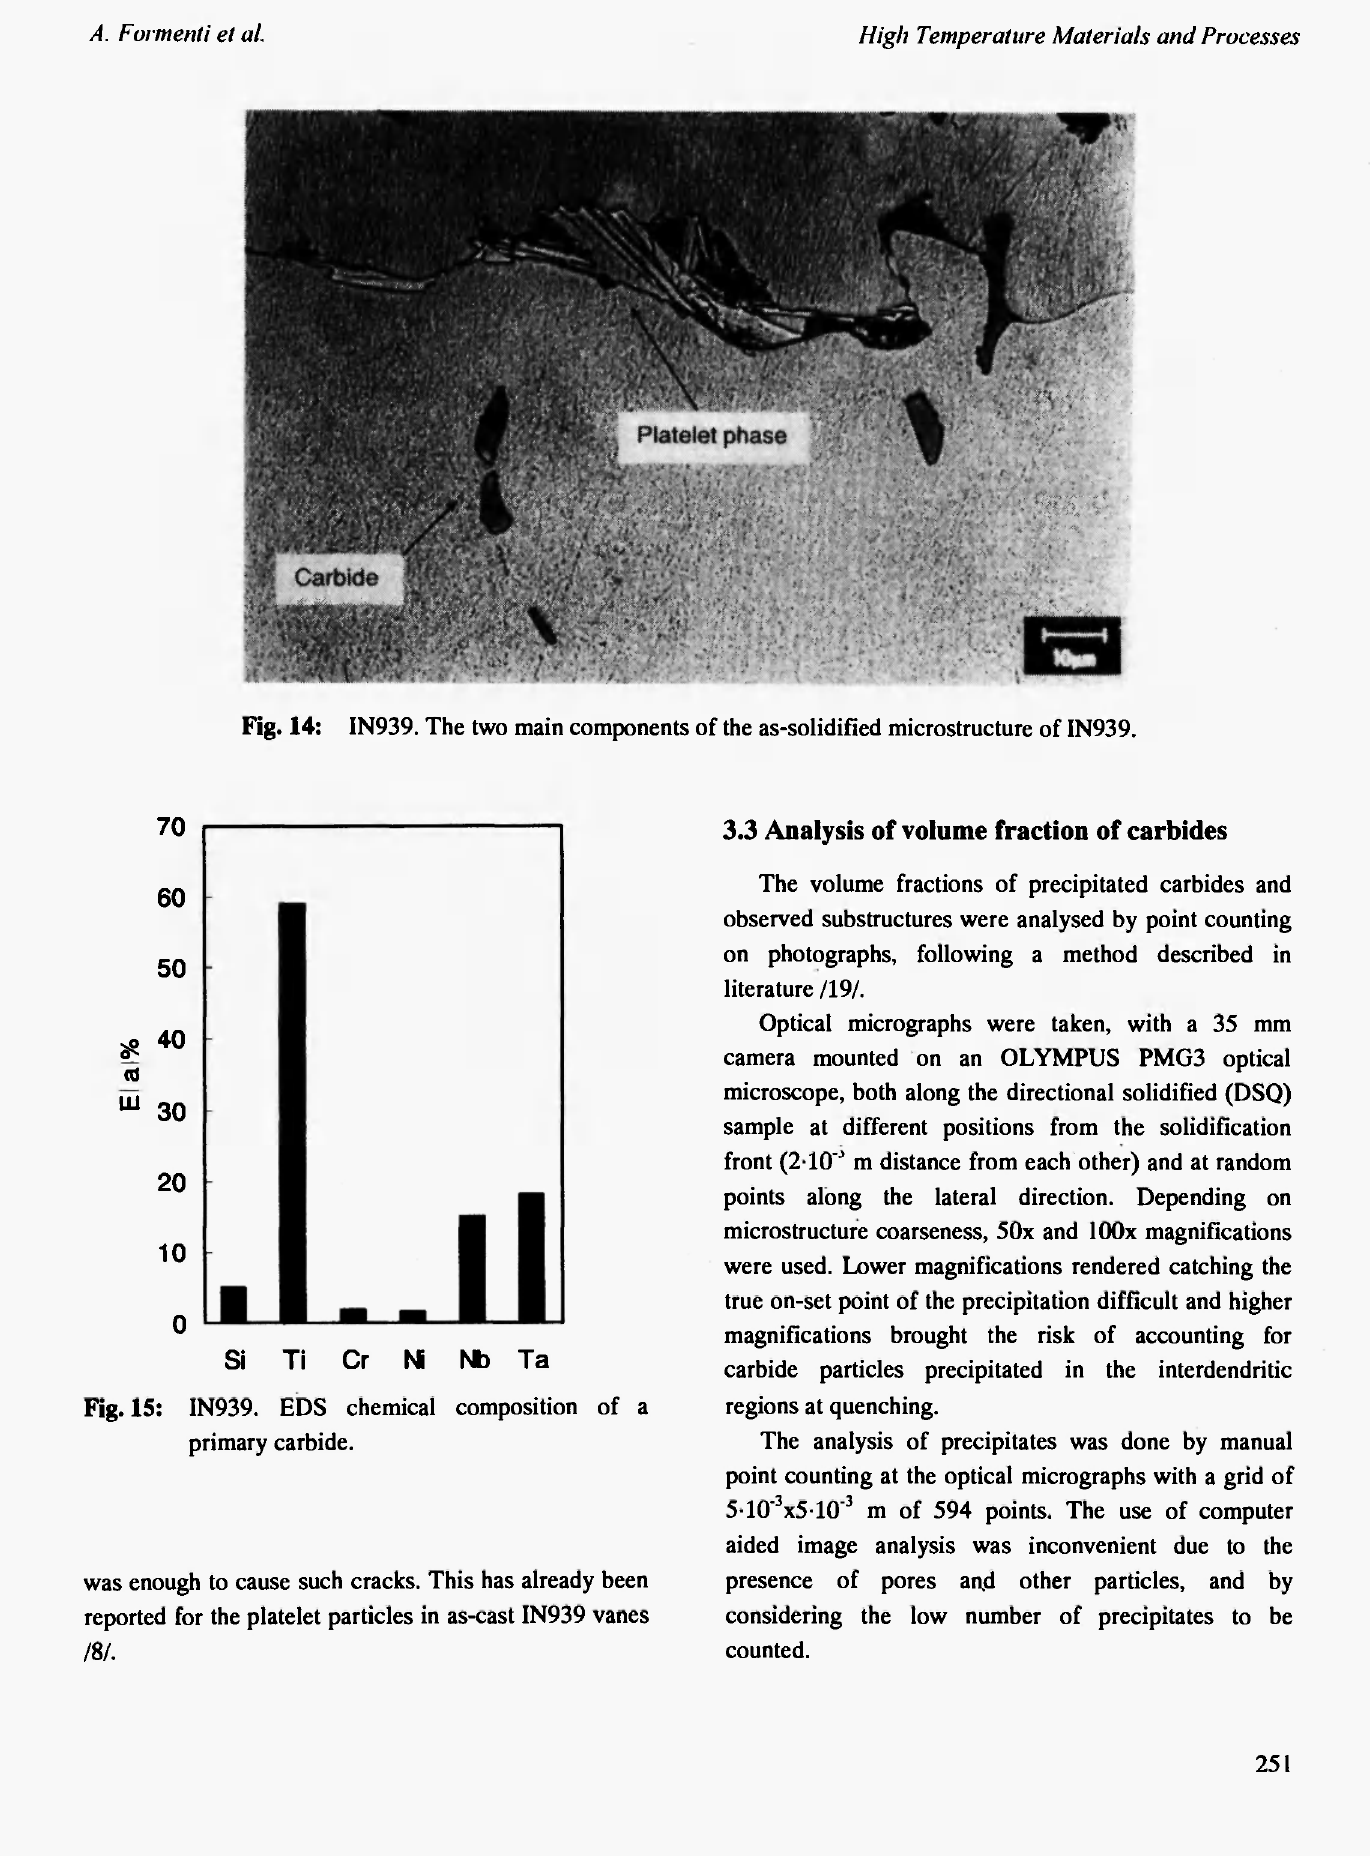
IN939. EDS chemical composition of a primary carbide.